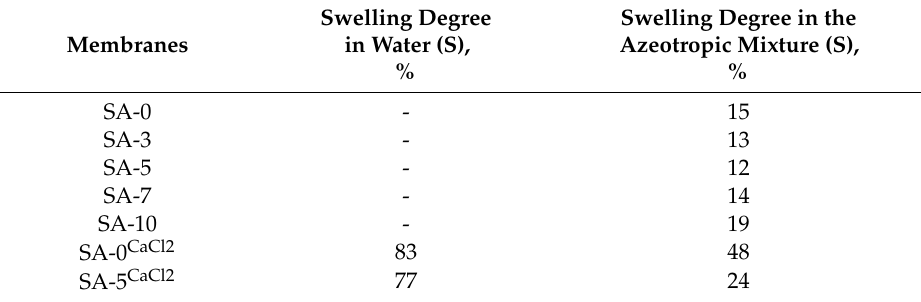
Table 5. Swelling degree of SA-based membranes in water and the water (12 wt %)–isopropanol (88 wt %) mixture.